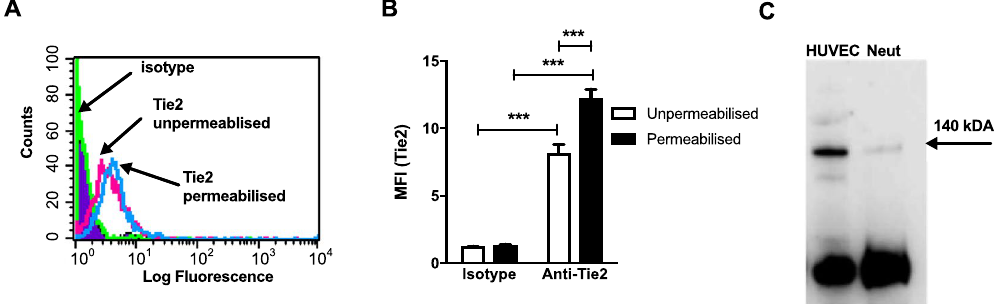
Figure 1. Tie2 expression on mouse peripheral blood neutrophils. ( A ) Ly6G positivity was used to gate on neutrophils using forward and side scatter and Tie2 expression demonstrated as a log shift in fluorescence (FL- 2) compared to isotype control. ( B ) For quantification of expression in unpermeabilised and permeabilised neutrophils, the mean fluorescence intensity (MFI) was determined. Results are presented as mean ± SEM (n = 3) and analysed for statistical significance using two-way ANOVA followed by Bonferroni’s post test for multiple comparisons. ( C ) Immunoprecipitation with anti-human Tie2 antibody resolved by SDS-PAGE- and probed with anti-mouse Tie2 antibody. Tie2 protein is detected at approximately 140 kDa. Lane 1: HUVEC lysate (positive control); lane 2: Mouse neutrophil